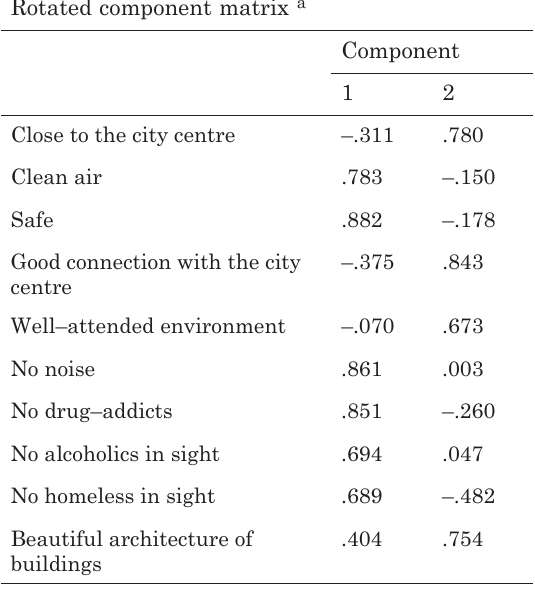
table 1. Correlation of variables with the factors